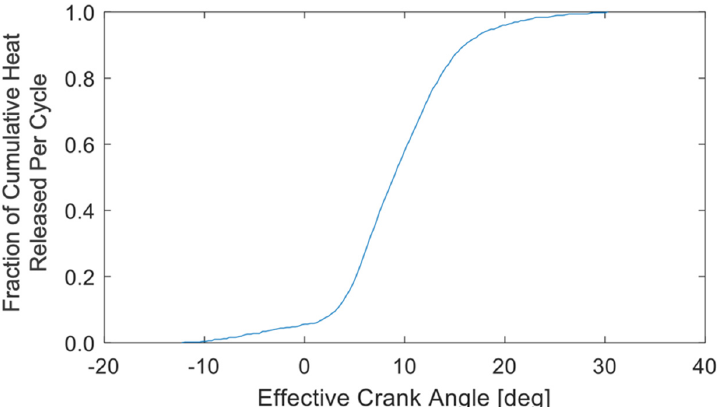
Figure 1. Combustion heat release profile adopted from previous work on GCI engines [39]. Table 3. Fuel properties for gasoline applied in the OP2S engine